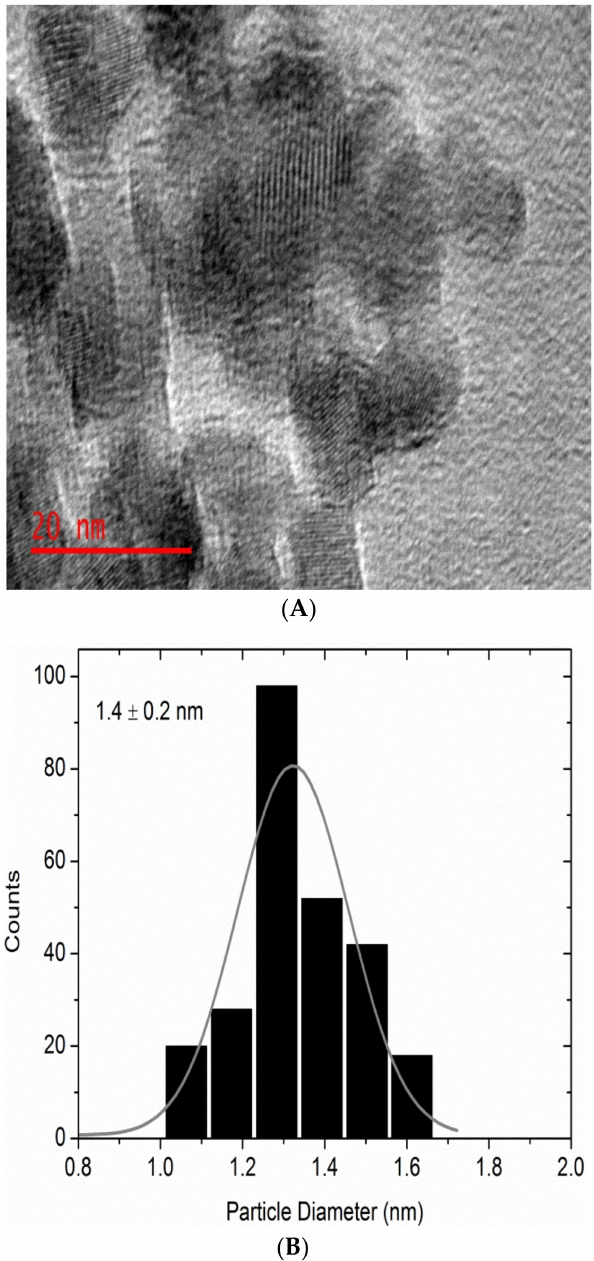
Figure 6. ( A ) HRTEM images of mesoporous titania supported Ru particles (Ru 40 @Meso-TiO 2 ) and ( B ) the corresponding particle size distribution histogram for Ru 40 @Meso-TiO 2. Reproduced from ref [75] with permission from